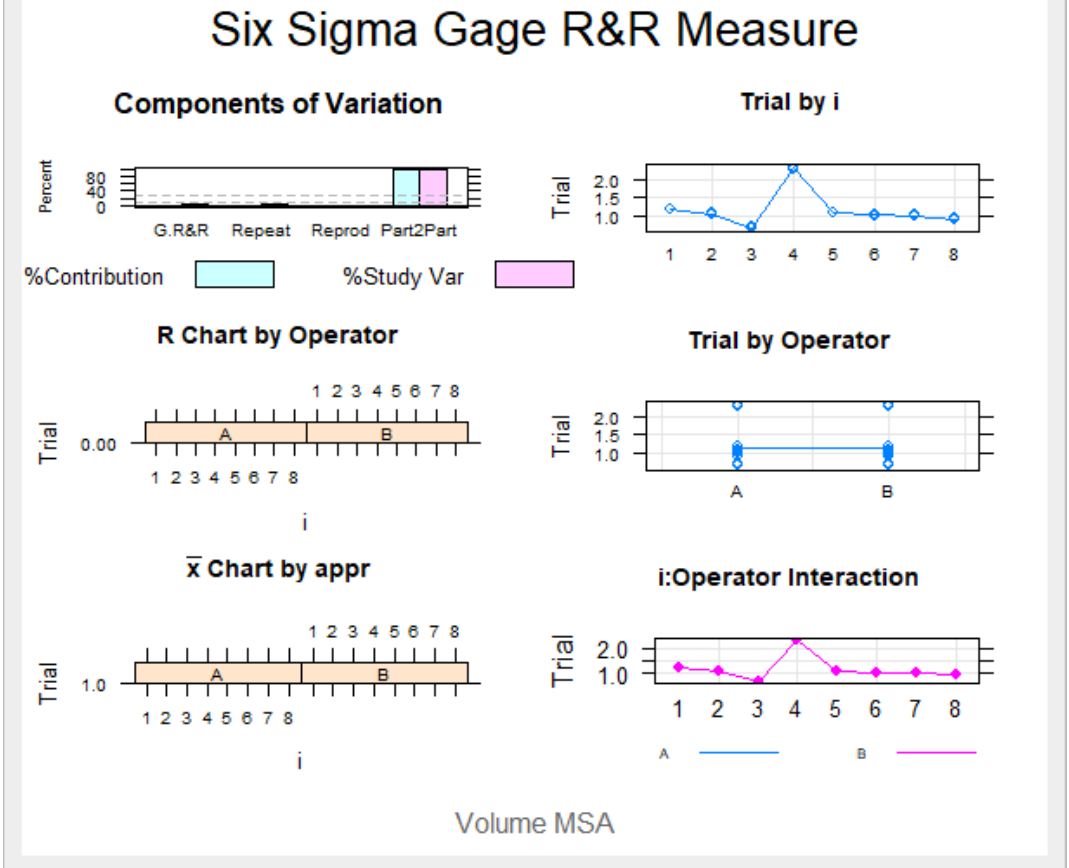
Figure 7. The graph shows the relationship of the volume measurement analysis after palatal suture expansion following RME procedures through the McNamara appliance, with the contribution graph of each component to the total variance (Variance Components), mean control chart and range control chart (R Chart by Operator and x Chart by appr), each measurement point on the graph (Assay by I and Assay by Operator) and the interaction between the operators (i:Operator interaction).